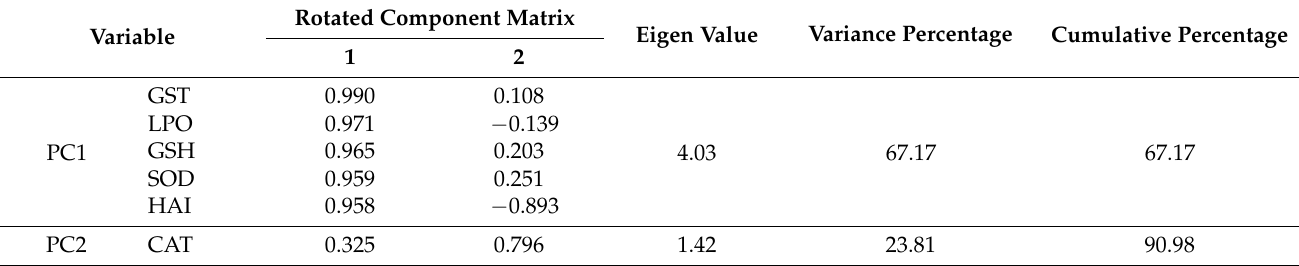
Table 2. Statistical parameters generated by PCA on various biomarkers in liver of C. carpio on 60 th day of the experiment. Rotated Component Matrix Eigen Value Variance Percentage Cumulative Percentage Variable 1